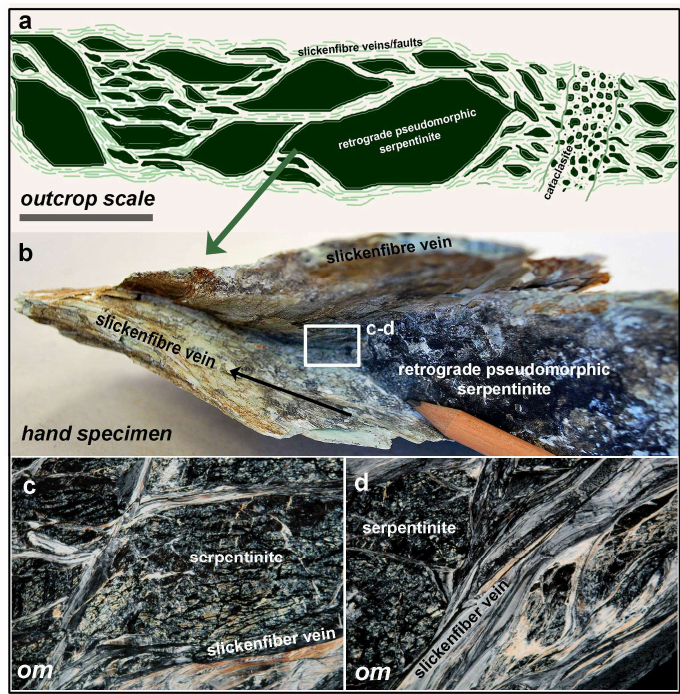
Figure 3. Common characteristics of retrograde serpentinite at a range of scales. ( a ) Dark-green lenses of massive serpentinite surrounded by pale-green, anastomosing slickenfibre-coated faults. Cataclasites are localised along late-stage faults that crosscut the previously-formed fabrics. Scale bar corresponds to ~3 m. ( b ) Hand specimen showing the contact between a massive serpentinite lens and a slickenfibre veins. ( c , d ) Polarised-light images (crossed nicols) from the contact between massive mesh textured serpentinite and slickenfibre veins; these microstructures are consistent with a dominant pressure solution–precipitation process.